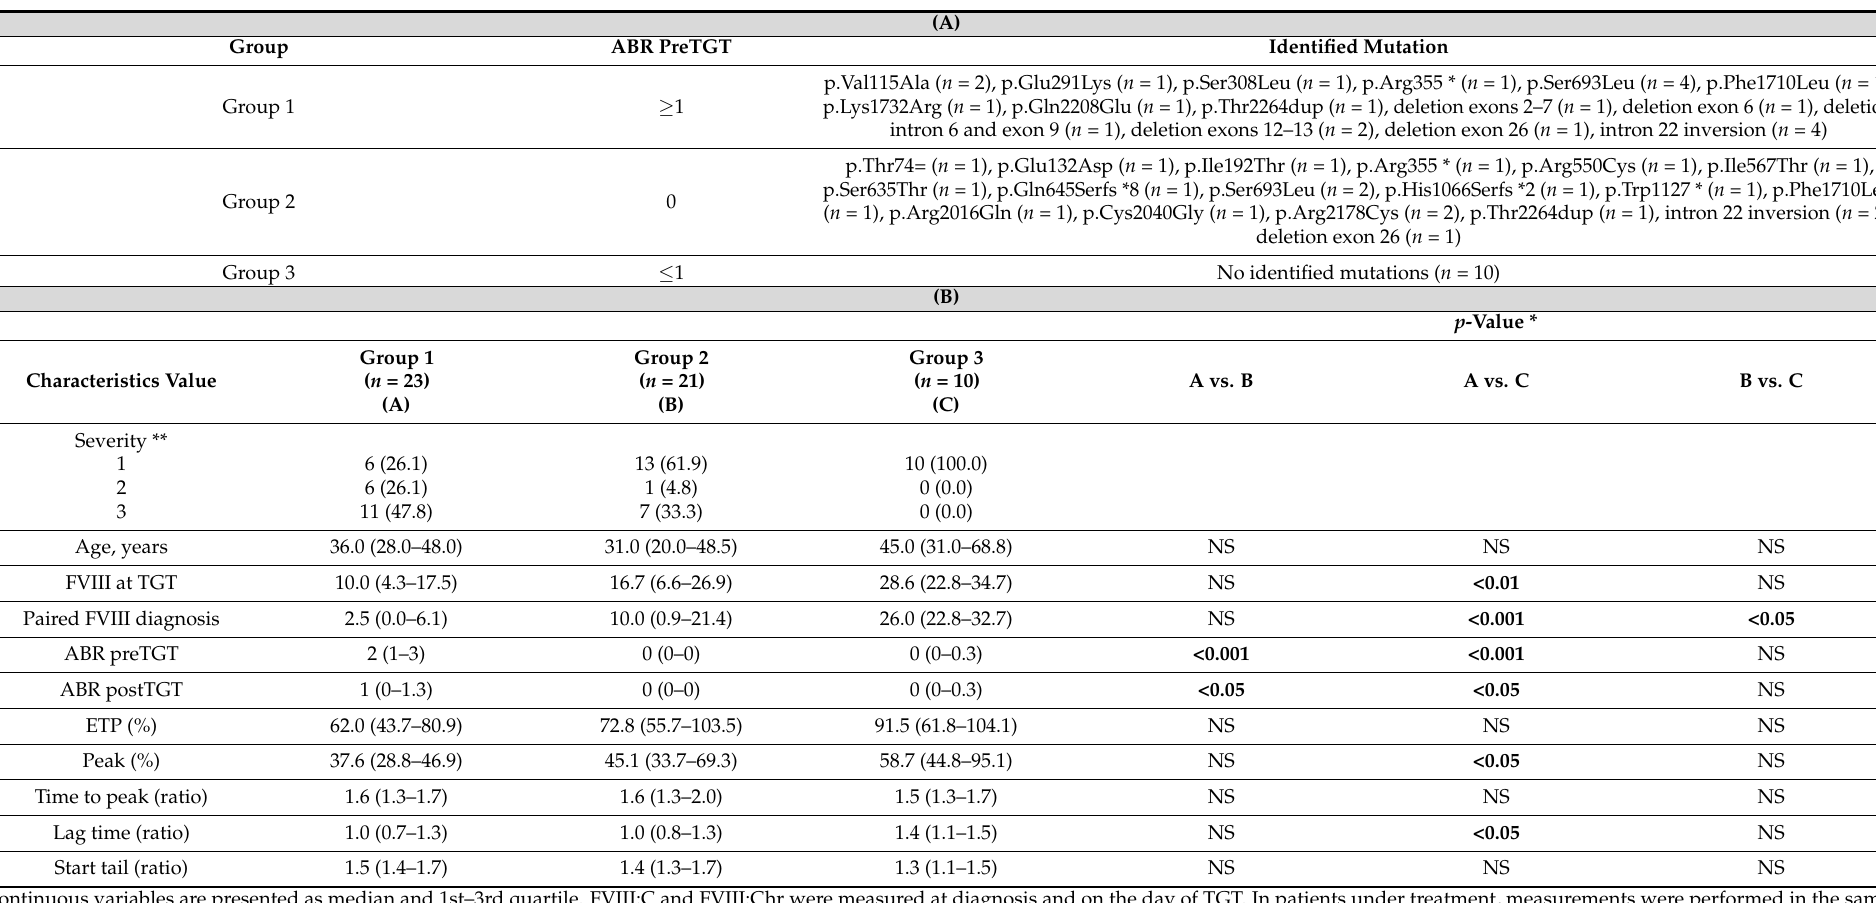
Table 5. Clinical characteristics of the HA patients according to the group of F8 mutations. ( A ) Identified mutations and ABR score based stratification of